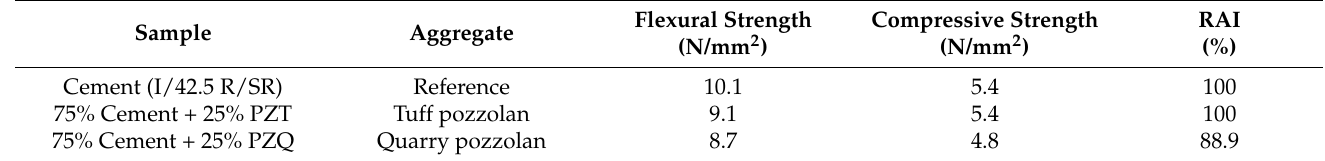
Table 6. Flexural strength, compressive strength, and resistance activity index of the additives in the reference